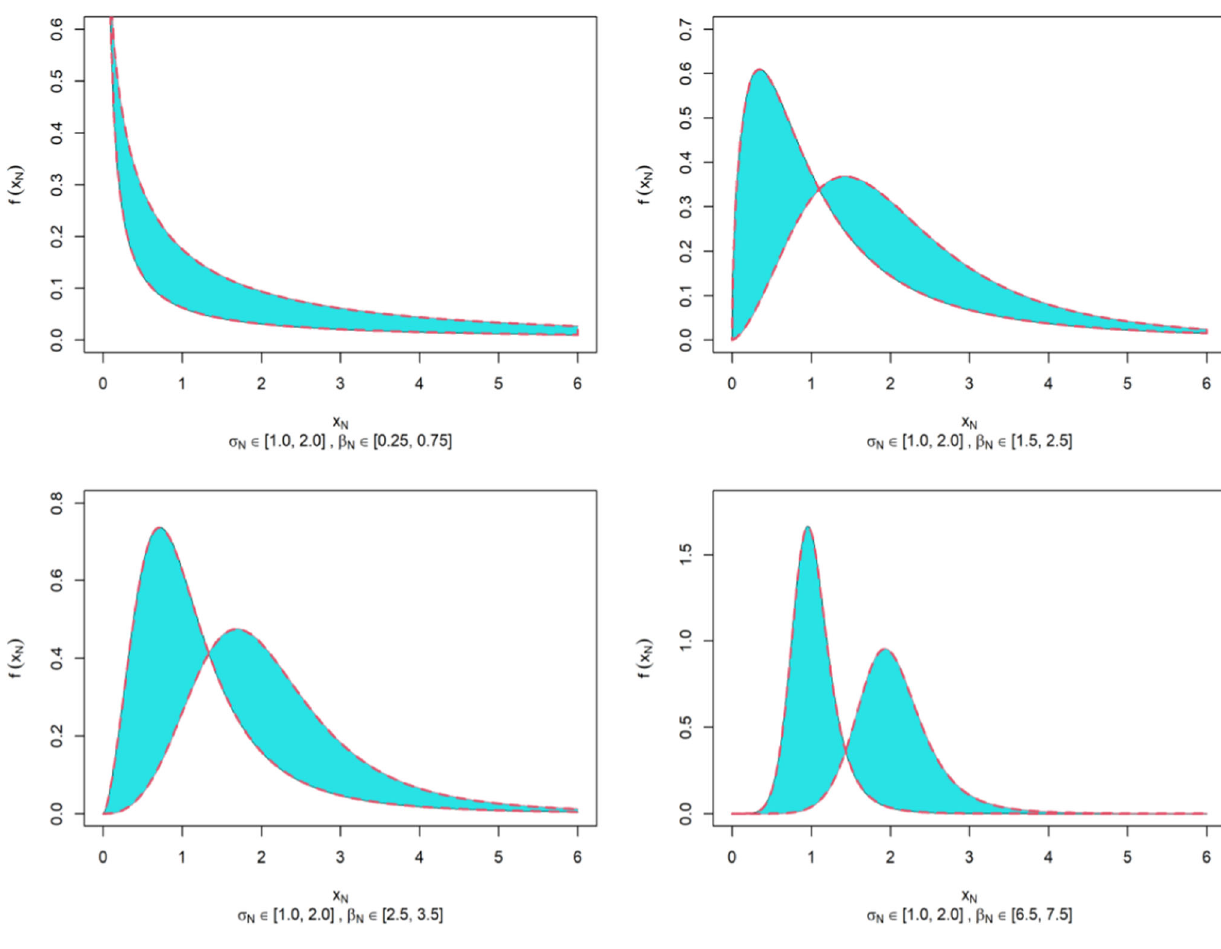
Fig. 1 The pdf curves of NLLD for various neutrosophic